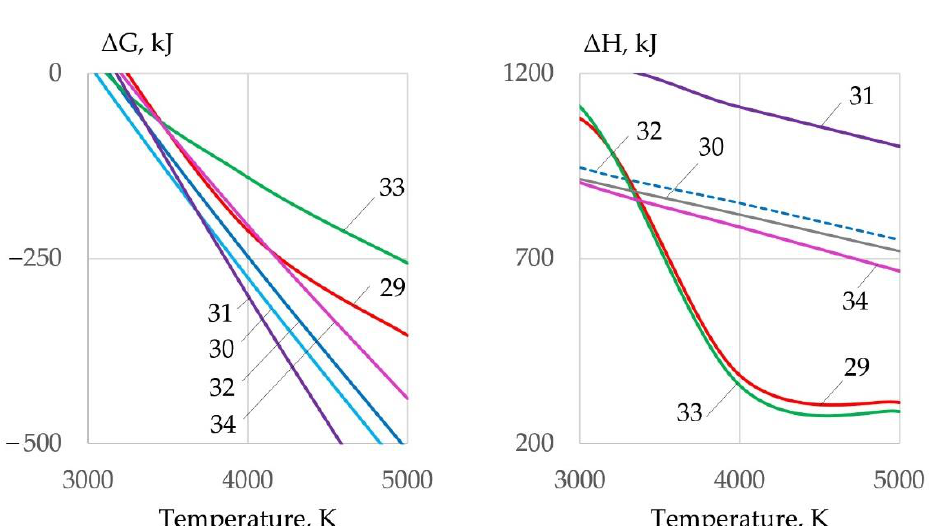
Figure 16. Change of Gibbs free energy and enthalpy of reactions ( 29 – 34 ) of the interaction of oxides with cryolite.